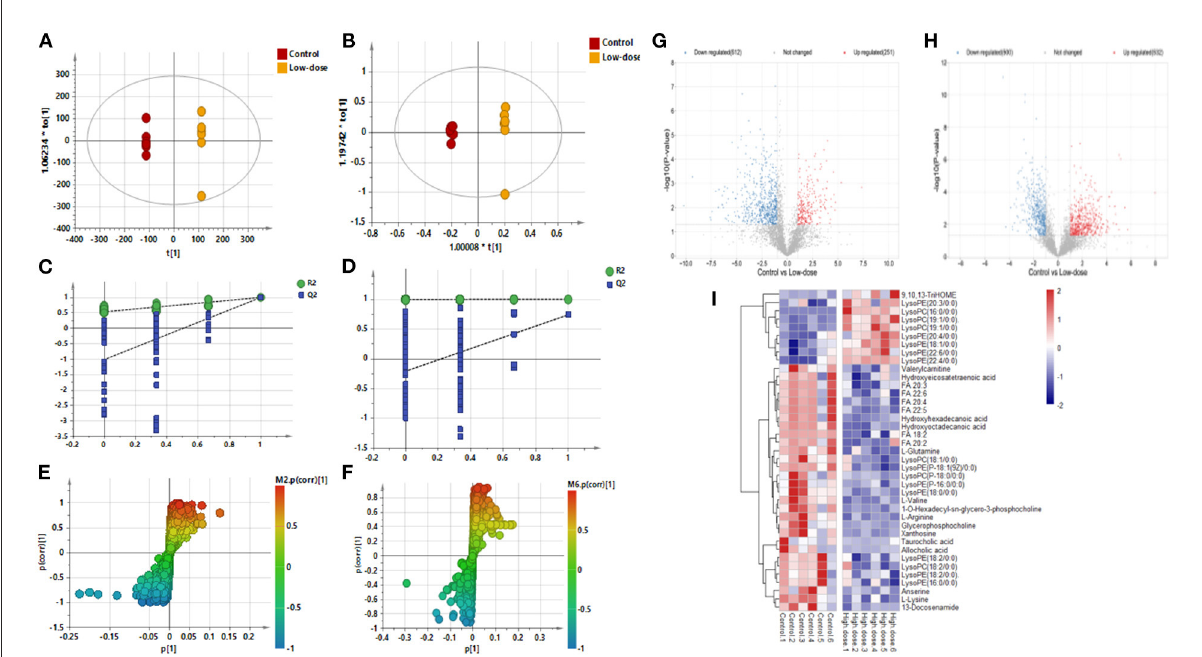
FIGURE2 OPLS-DA: Control vs. Low-dose. (A) Negative ions (R 2 X 0.915, R 2 Y 1.000, Q 2 0.992), (B) Positive ions (R 2 X 0.857, R 2 Y 0.999, Q 2 0.738), (C) Negative ion replacement test, (D) Positive ion replacement test. (E) Negative ion S-plot, (F) Positive ion S-plot. (G,H) Volcano diagram. (G) Negative ions, (H) Positive ions. ‹ Fold change (M/C) > 2 or < 0.5, and › P < 0.05 was the effective variable. Blue means down, red means up. (I) Control vs. Low-dose differential metabolite heat map. The darker the red, the higher the response, and the darker the blue, the lower